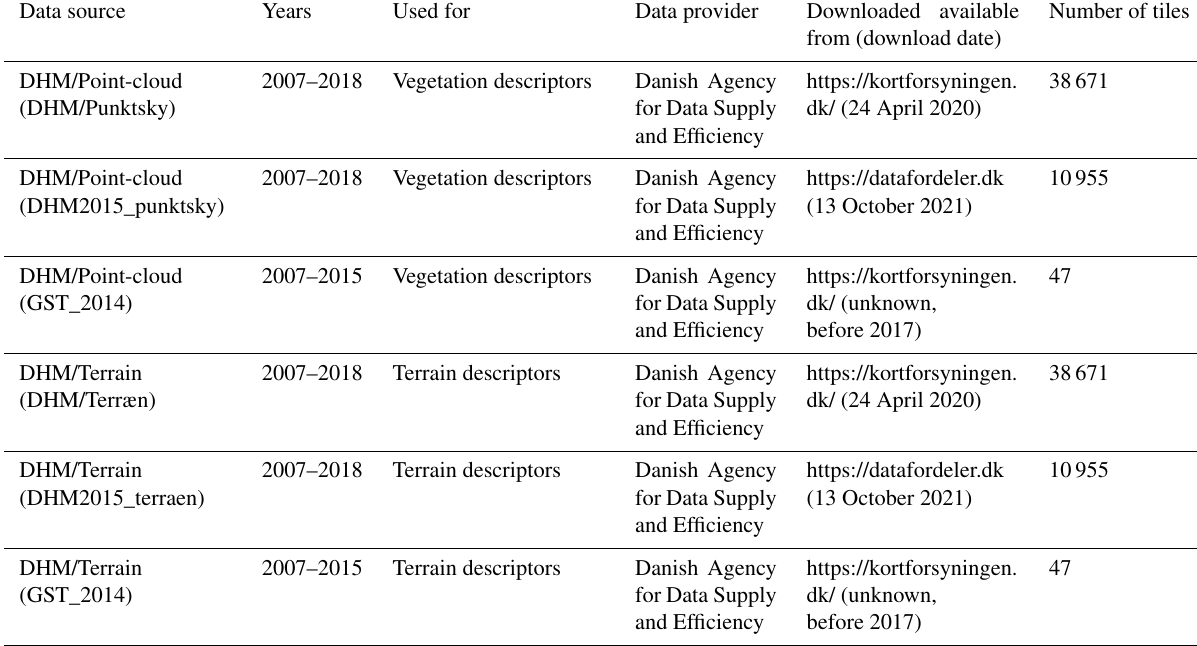
Table 1. Overview of the data sources used for generating the EcoDes-DK15 data set. Three versions of the DHM/Point-cloud were merged to obtain a point cloud data set that contained no vegetation points scanned after 2015 and as little vegetation points before 2014 as possible. DHM/Terrain tiles were matched sources from the same data source as the corresponding point cloud tiles. A copy of the source data is archived on the internal long-term data storage at Aarhus University and is available on request. For further information see documentation on GitHub code repository and Sect.